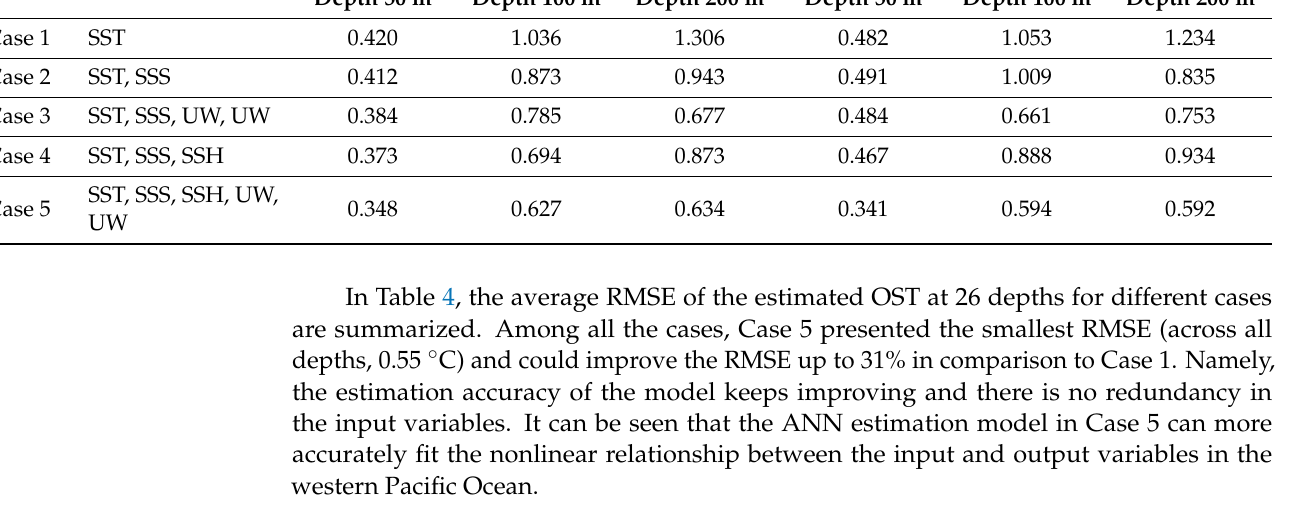
Table 4. Performance of the estimated OST vertical structure at 26 depths for each